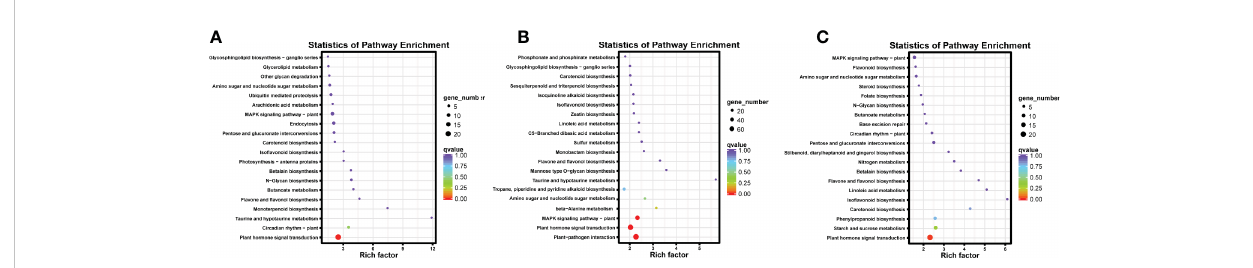
FIGURE 3 Results of gene and genome enrichment analysis of DEGs in leaves (A) and roots (B) and stems (C) of K. obovata seedlings before and after the cold snaps and Kyoto Encyclopedia of Genes and Genomes (KEGG) pathway. The horizontal coordinates represent the degree of enrichment, the different colors represent the size of the p-value, and the size of the dots represents the number of